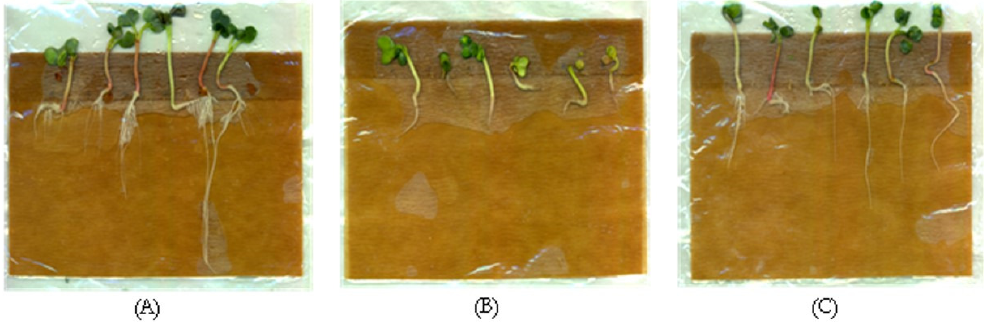
Data are reported as the mean ± SD of five parallel measurements. Values with different superscripts (a, b, c) in the same column differ significantly (LSD test, p < 0.05).